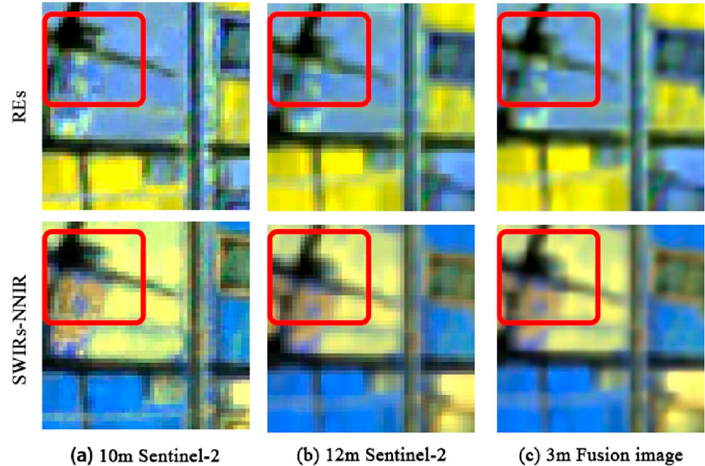
Figure 5. Comparison of true (R,G,B) and false (NIR,R,G) color of 10 m Sentinel-2 ( a ), 12 m Sentinel-2 ( b ), 3 m Planet ( c ), and 3 m fused images ( d ).